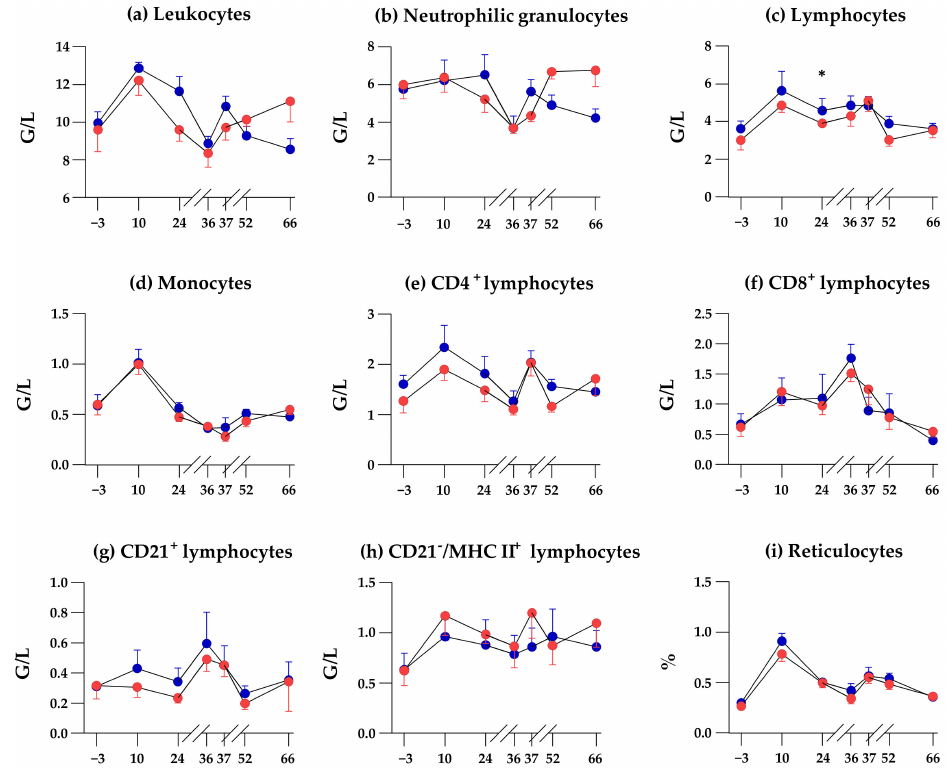
Figure 5. Changes in leukocyte counts (( a ), blood leukocytes subpopulations; ( b ), neutrophilic granulocytes; ( c ), lymphocytes; ( d ), monocytes; ( e ), CD4 + T cells; ( f ), CD8 + T cells; ( g ), CD21 + B cells; ( h ) CD21 MHC II + lymphocytes) and reticulocyte percentages ( i ) in the blood due to feeding. Cell counts of ( a ) and percentage of reticulocytes were determined by flow cytometry on days − 3 (before supplementation), 10, 24 (during supplementation), 36 (during supplementation and day of vaccination), 37 (after vaccination), 52 and 66 (after supplementation). Shown are the responses per group (OLI in red, n = 6; PLA in blue, n = 5). The p -value was determined with the two-sample- test or the Wilcoxon test and describe the significance between the two groups per sampling day. Significance is present if the p -value is <